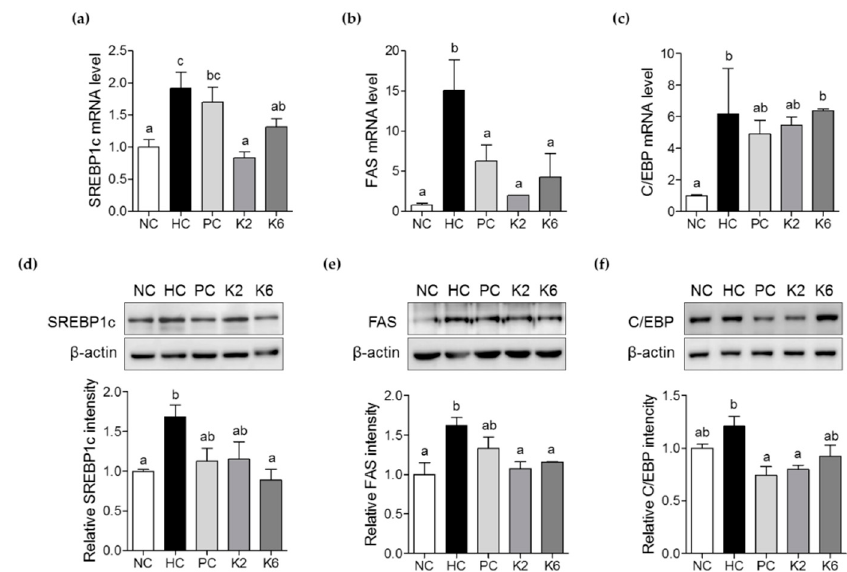
Figure 6. E ff ects of K2 and K6 on mRNA and protein expression of lipogenesis-related genes in the rat model of HF / HF-induced NAFLD. mRNA expression level of ( a ) SREBP-1c, ( b ) FAS, and ( c ) C / EBP in the liver. Western blot analysis of ( d ) SREBP-1c, ( e ) FAS, and ( f ) C / EBP expression in the liver. NC, normal diet control; HC, HF / HF diet control; PC, HF / HF diet with silymarin; K2, HF / HF diet with ATG-K2; K6, HF / HF diet with ATG-K6; SREBP-1c, sterol regulatory element binding protein 1c; FAS, fatty acid synthase; C / EBP, CCAAT / enhancer-binding protein. The data are presented as mean ± SD. Means with di ff erent letters (a, b) are significantly di ff erent, p < 0.05, whereas those with similar letters are not di ff erent. The groups were compared using one-way ANOVA followed by Duncan’s multiple range